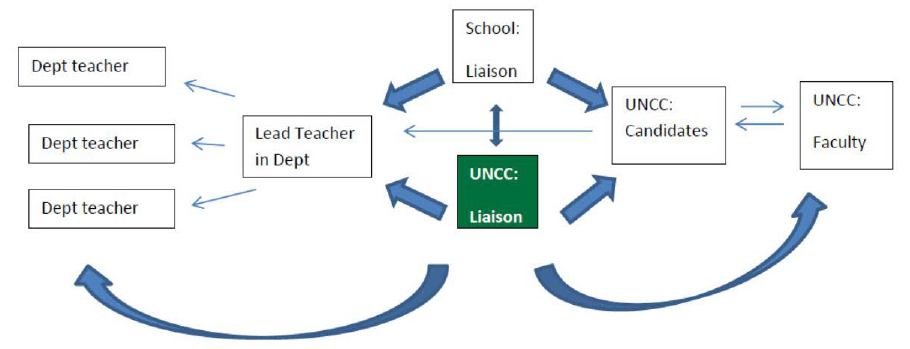
Fig. 1 The basic structure of the informatisation teaching